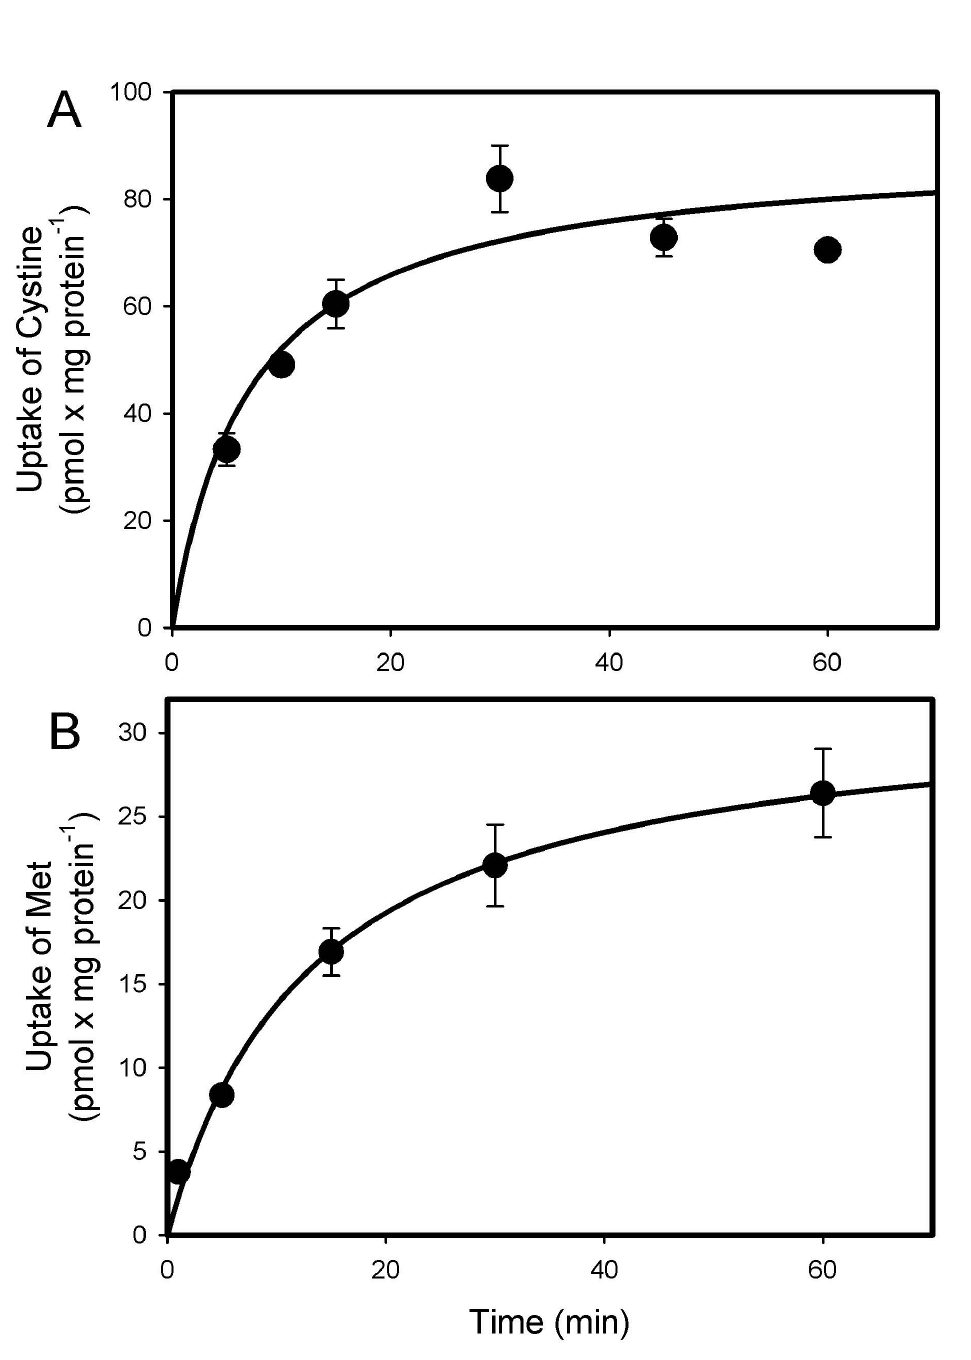
Figure 1. Uptake of 5 µ M [ 35 S]-cystine ( A ) and 5 µ M [ 3 H]-methionine ( B ) in BeWo cells. Uptake was carried out at 37 ◦ C for various times between 5 and 60 min. Results are presented as mean ± SE. Data represent 3 experiments performed in